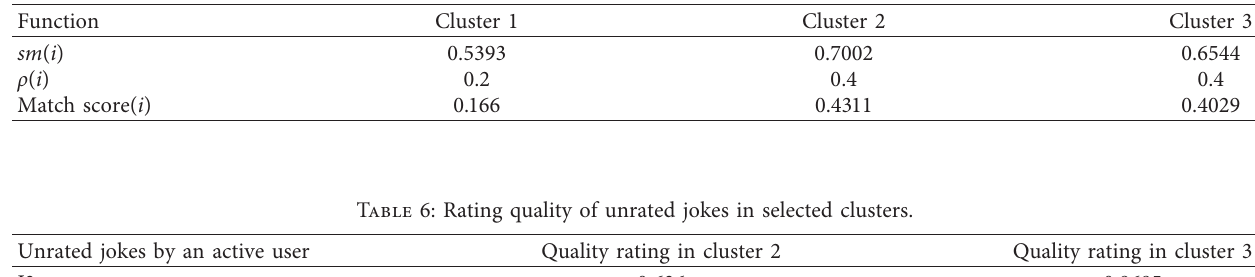
Table 5: Cluster selecting